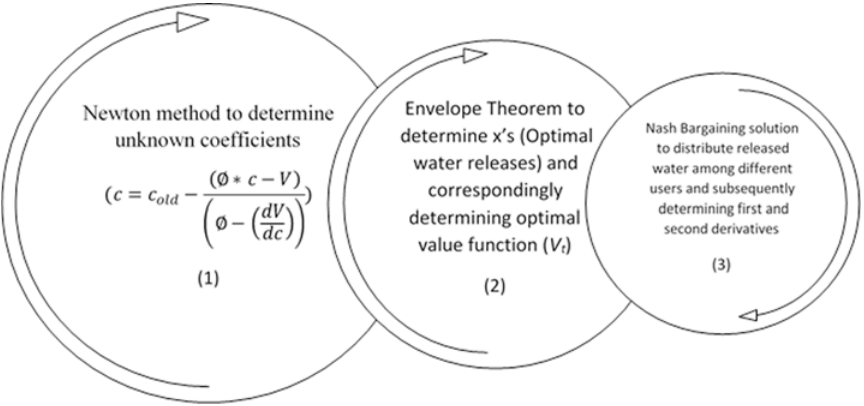
Fig 1. Sequential steps to solve Eq